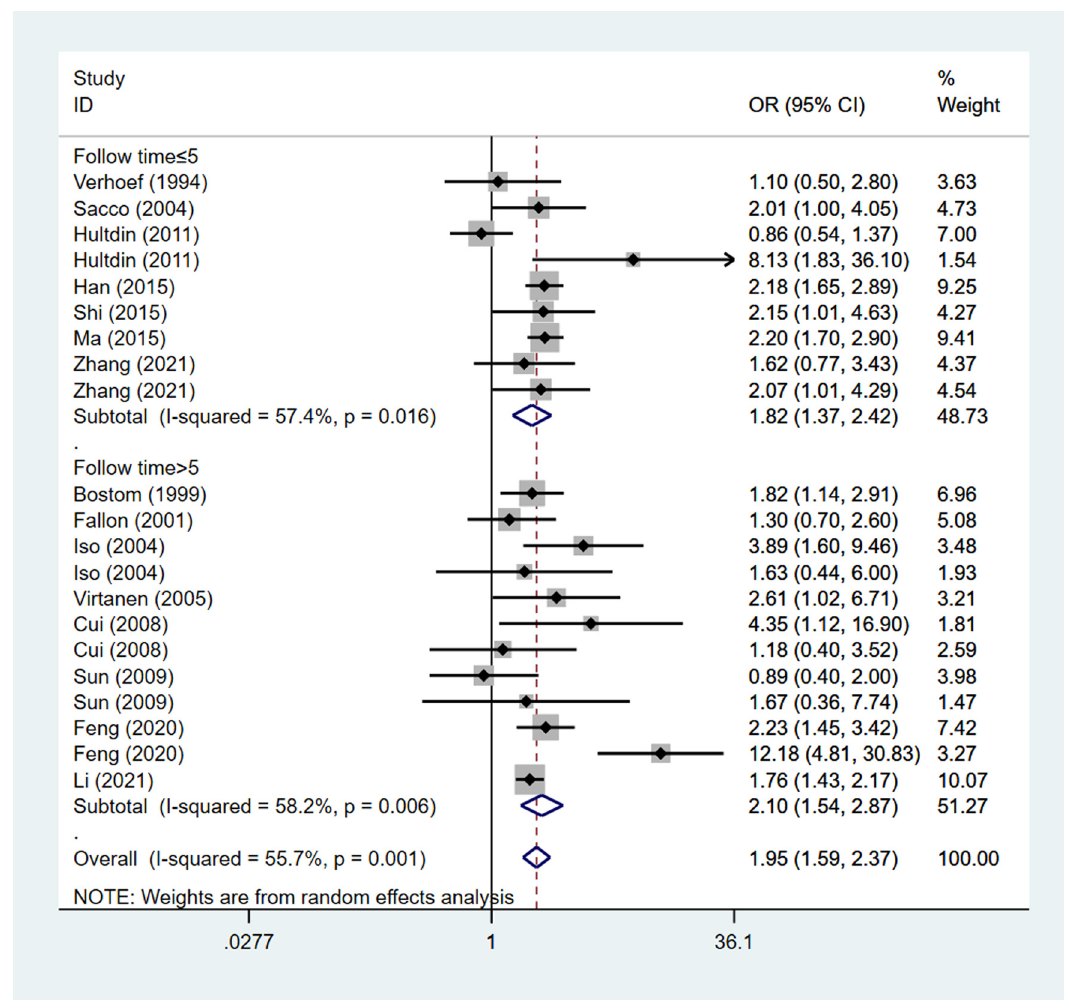
Figure 2: Forest plots showing the e ff ect of elevated Hcy levels on strokes. High Hcy levels increased the risk of fi rst - time stroke ( OR = 1.95 ) . Subgroup analysis showed that high Hcy levels were associated with an increased risk of fi rst - time stroke regardless of follow - up